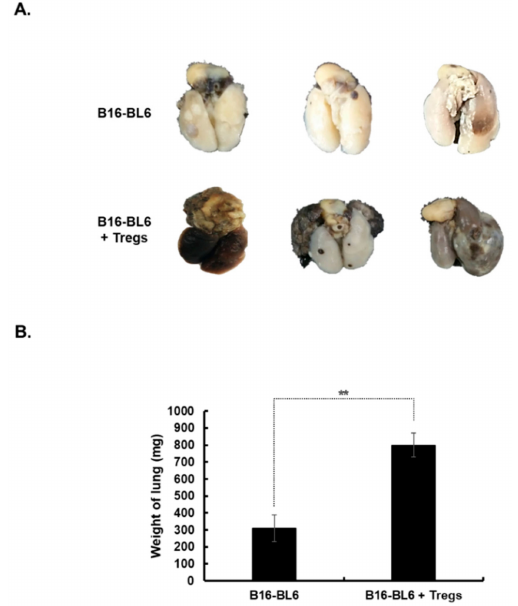
Figure 6. Induction of metastasis following injection with Tregs. Subcutaneously established B16-BL6 tumors located on the right foot pad were intratumorally injected three times with Tregs (1 × 10 6 cells) and then surgically excised at 5 days after the final Treg injection. On day 25 after primary tumor removal, the lung tissues encompassing both normal and cancerous regions were weighed. ( A ) Representative macroscopic view of lungs from each group. These images are representatives from three independent experiments. ( B ) Comparison of the lung tissue weight from each group. Data represent mean ± SD of results from three mice per group. ** p <